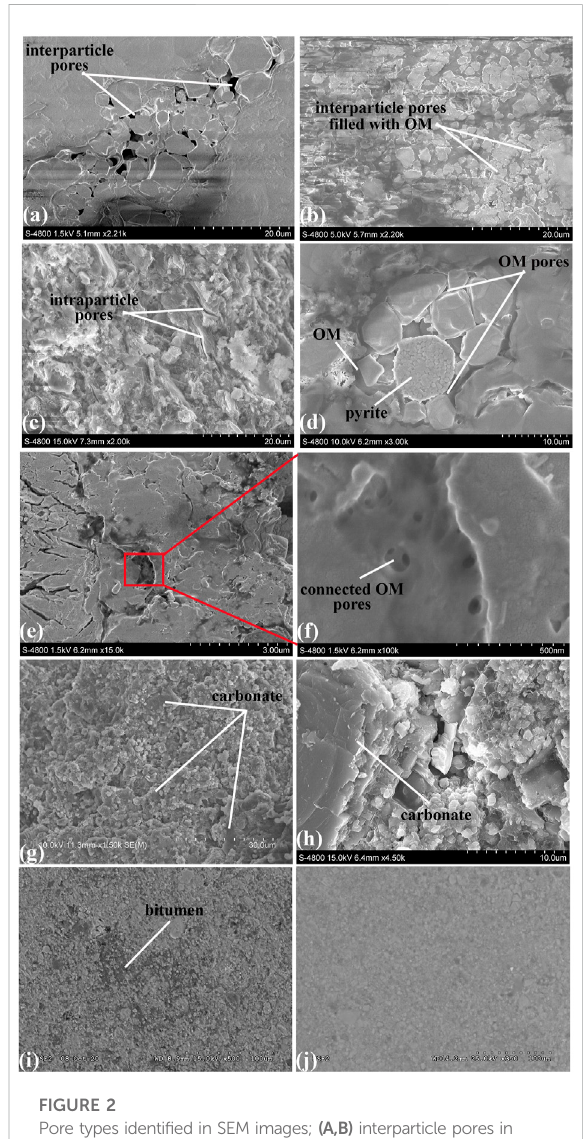
FIGURE 2 Pore types identi fi ed in SEM images; (A,B) interparticle pores in WFD-4 and WFD-9; (C) intraparticle pores in WFD-5; (D) OM pores and pyrite in WFD-4; (E,F) connected OM pores in WFD-6; (G) carbonate in WFD-8; (H) carbonate in WFD-4; (I) BSE image of WFD-6 before solvent extraction; (J) BSE image of WFD-6 after solvent